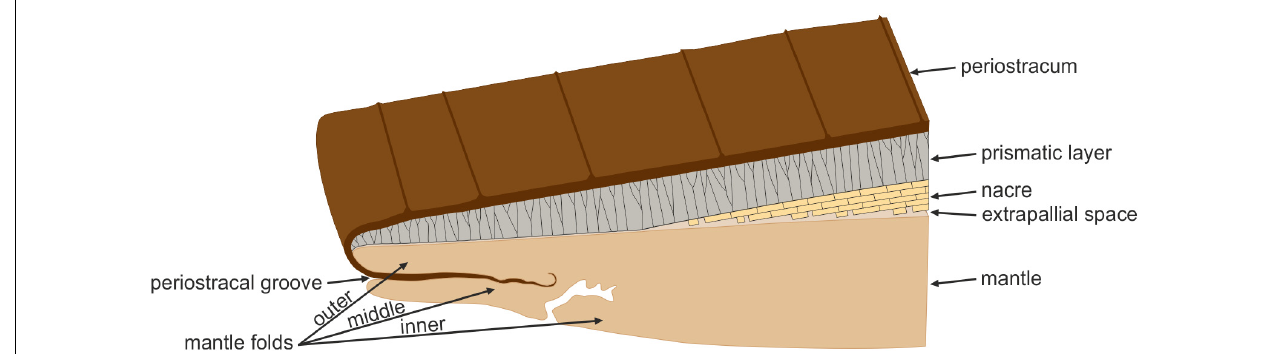
FIGURE 2 | The bivalve mollusc biomineralization system. The mantle is separated from the shell by the extrapallial space. The first component to be secreted is the periostracum, at the groove between the outer and middle mantle folds. The mineral shell layers are secreted by the outer surface of the outer mantle fold. The archetypical prismato-nacreous shell is used for the